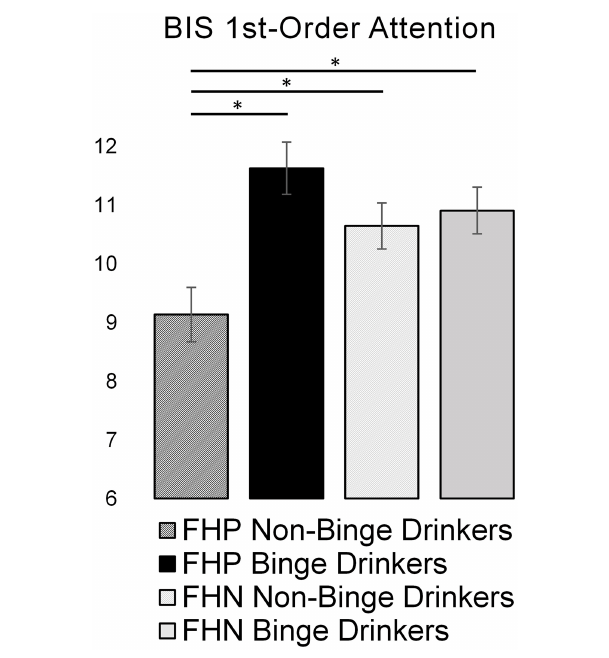
FIGURE 1 | Bar graph representing the effects of family history of alcohol use disorder and binge drinking on Barrett Impulsiveness Scale (BIS) first-order attention scores. Greater attention scores represent more attention problems. Asterisks (*) denote significant group differences ( p < 0.05). FHP, family history positive; FHN, family history negative.